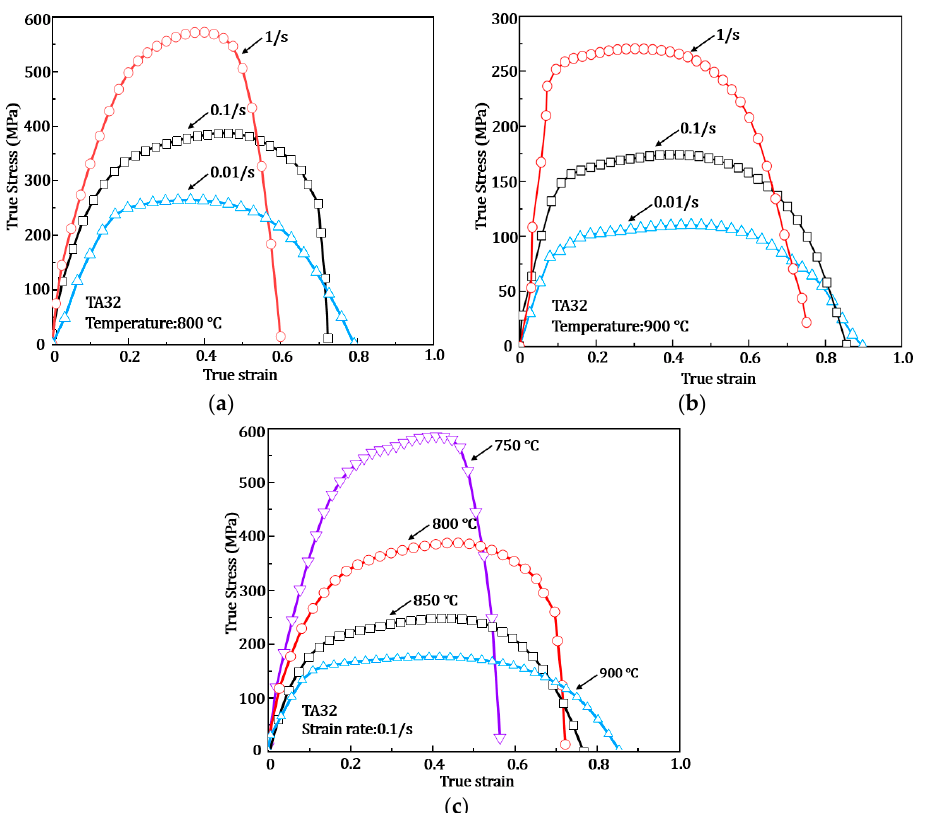
Figure 10. True stress-strain curves of the TA32 at different temperatures and strain rates after correction: ( a ) 800 °C; ( b ) 900 °C; ( c ) 0.1/s.